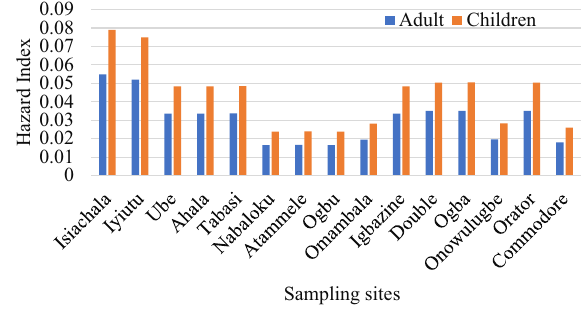
Fig. 10 Hazard index of populace across different sampling